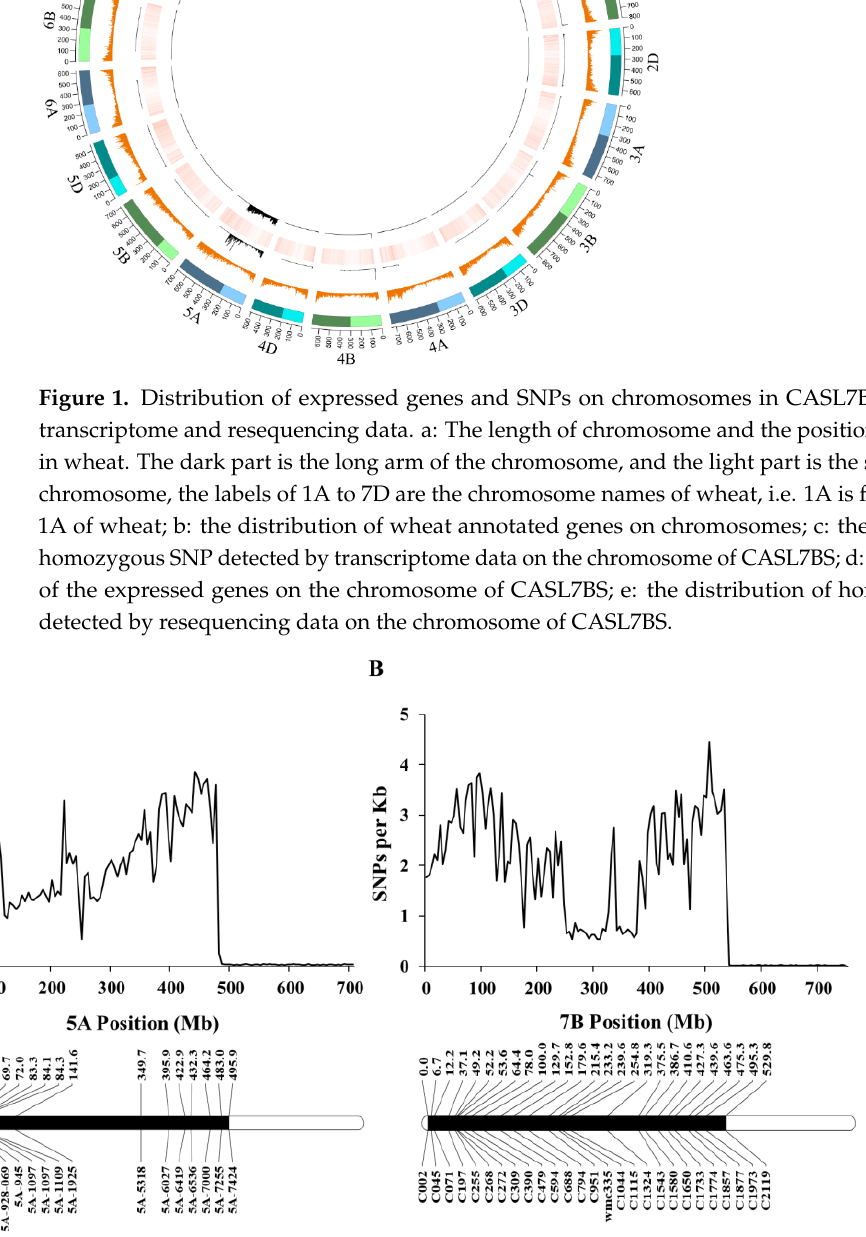
Figure 2. Distribution of homozygous SNPs between CS and TTD140 on chromosomes 5A ( A ) and 7B ( B ) in CASL7BS based on resequencing (above). The structure of chromosomes 5A and 7B identified by SSR are presented below. The black fragment represents the DNA segment from TTD140 and the white one from CS.